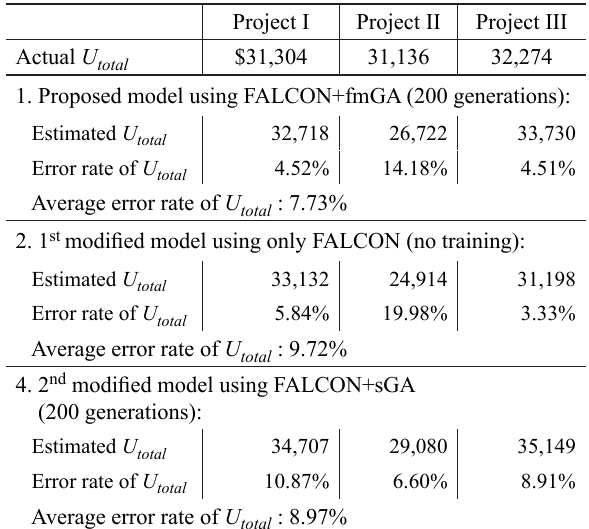
Table 9. Comparisons of error rates of U total using various esti- mation methods for three case projects